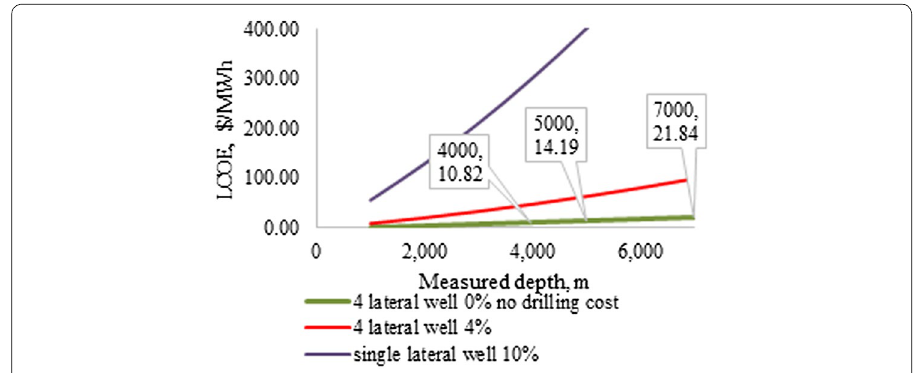
Fig. 21 LCOE for the 220 °C reservoir